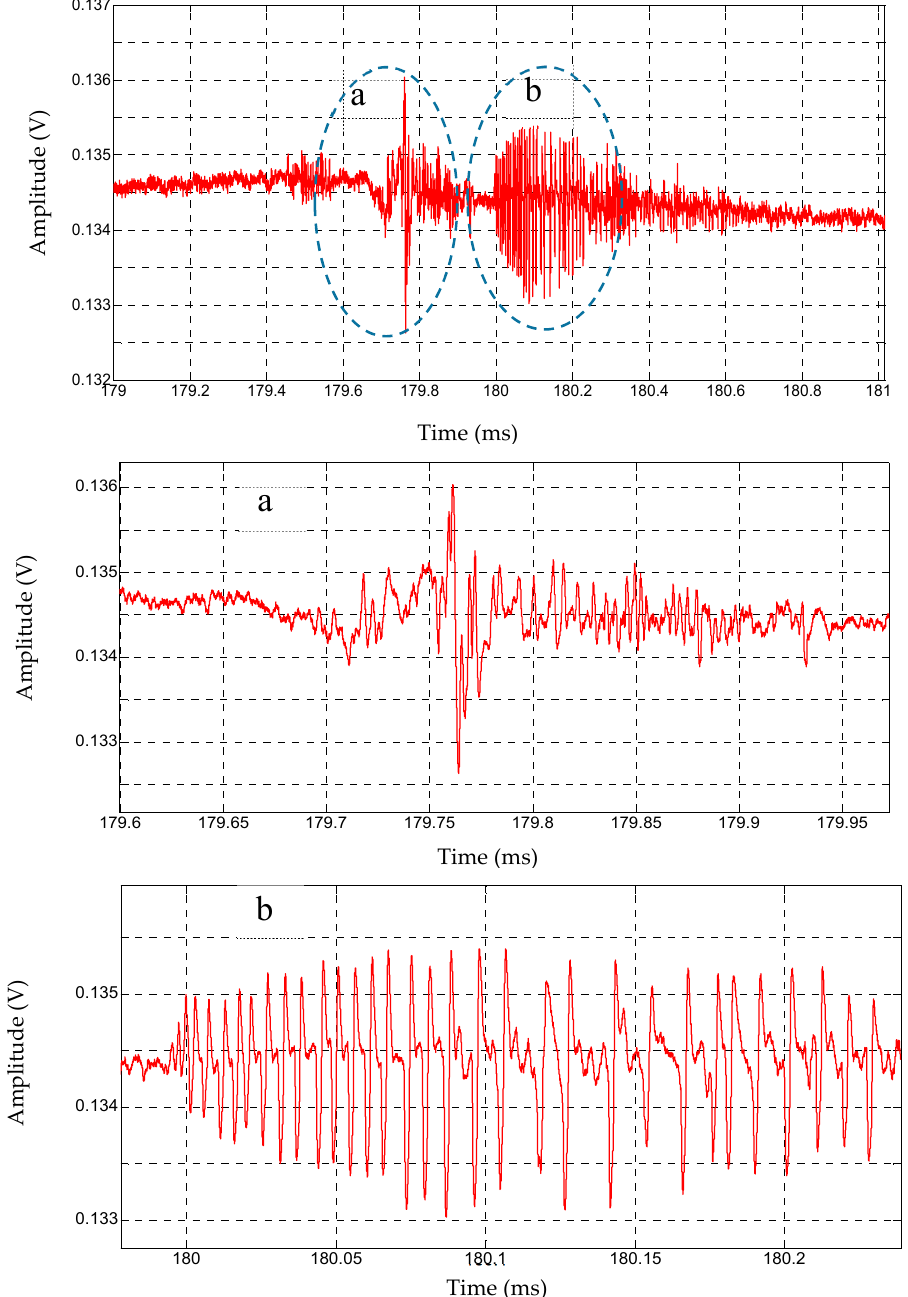
Figure 6. K-change starting with a chaotic pulse train and ending with a regular pulse train circled in dotted blue lines. Figures ( a , b ) shows the expanded view of chaotic and regular pulse components. Data were recorded on 5/5/2013 08:04:00. UTC.